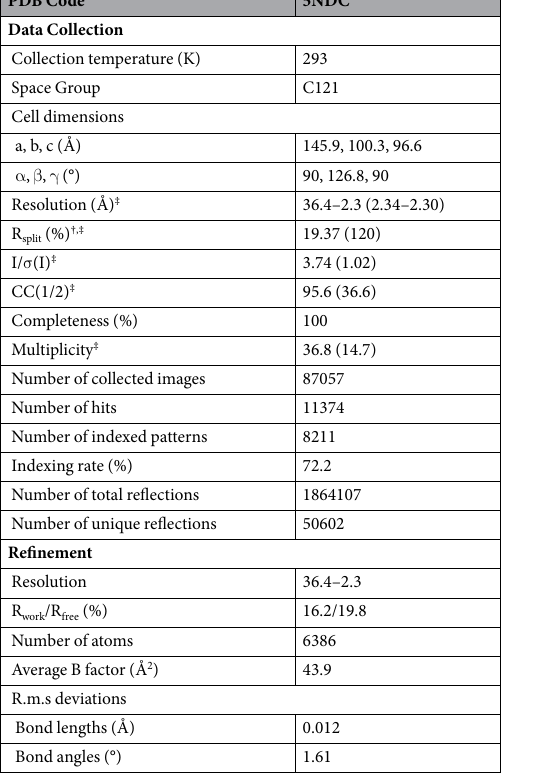
Table 1. Data collection and refinement statistics. † = . ‡ Values in parenthesis is those of the highest resolution